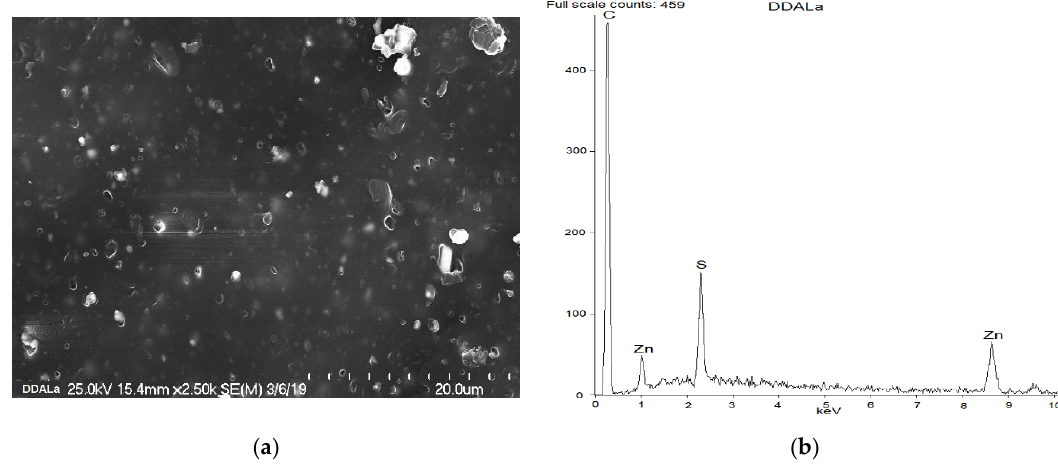
Figure 21. Dispersion of curatives in EPDM vulcanizate containing DDALa: ( a ) SEM image; ( b ) EDS analysis.